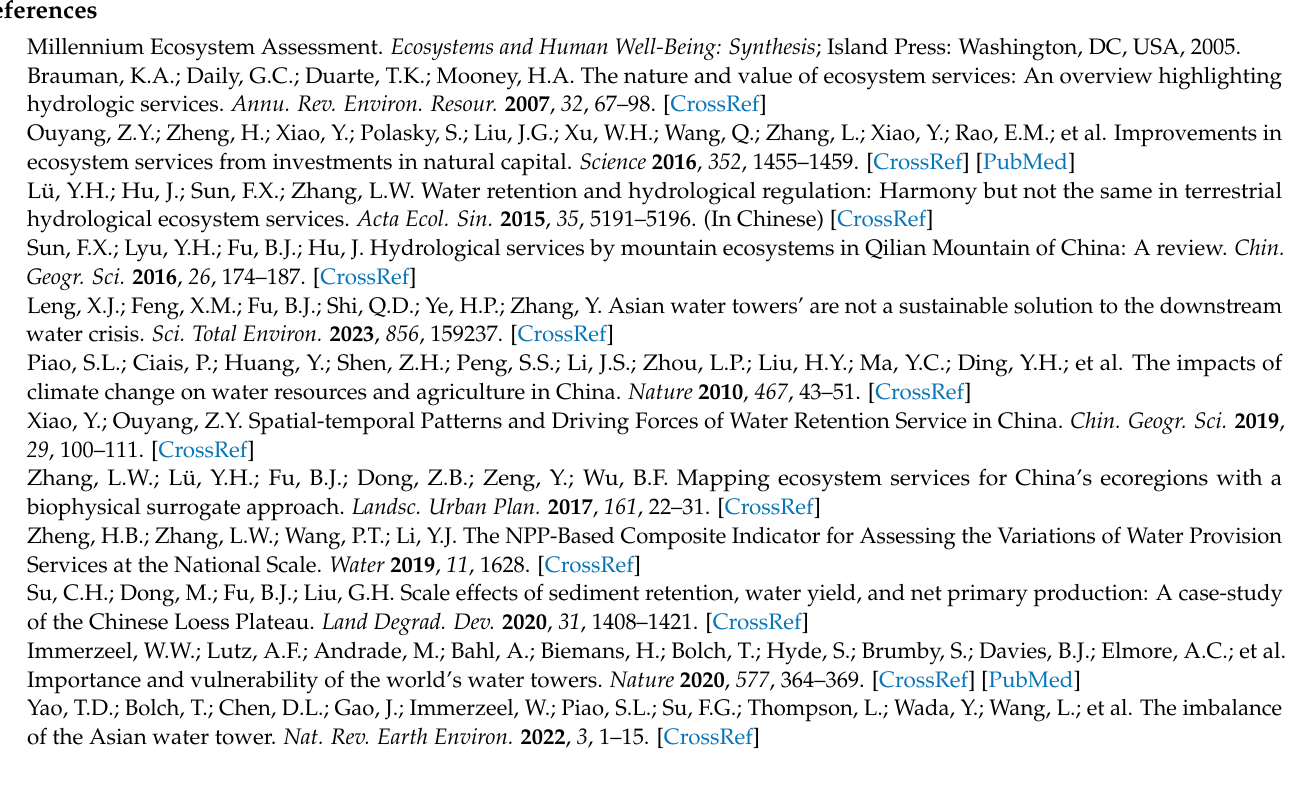
Table S2: Areas of different water retention pixel values from 2000 to 2015 based on five models; Table S3: Total water retention amount of various land types by models; Table S4: Changing areas of different pixel values in the study area from 2000 to 2015 for five